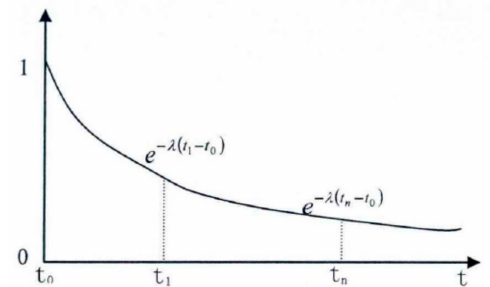
Figure 2. Diminishing curve reflecting the future time influence.